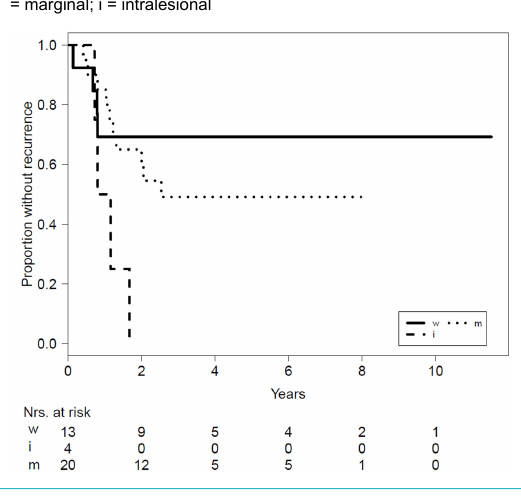
Figure 3: Kaplan-Meier curves for recurrence comparing the differ- ent surgical margins (). Table shows the overall incidence (%) re- ported, with hazard ratios (HR) and 95% confidence intervals (CI) calculated from a Cox-proportional hazard regression.w = wide; m